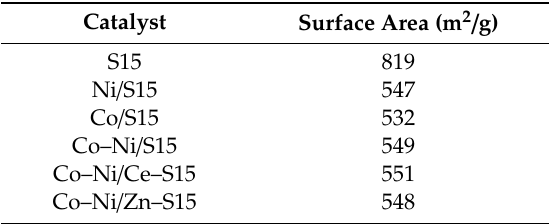
Table 1. Surface area of catalysts under